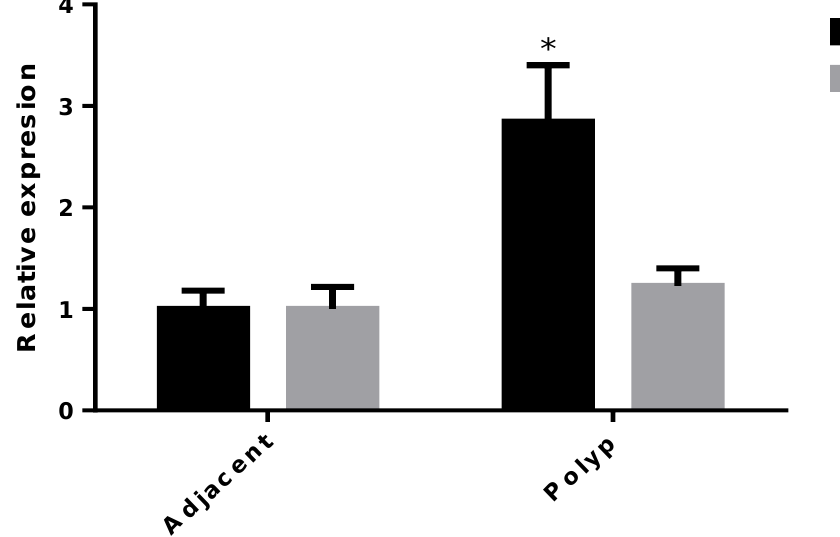
Figure 4. TP53 and PCNA expression in polyp vs. adjacent tissue. Data are expressed as 2 − ddCt . * p < 0.05 vs. adjacent.